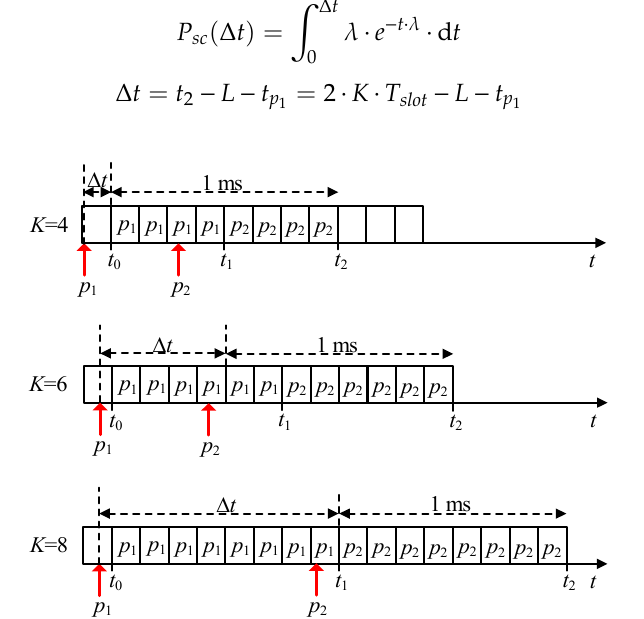
Figure 2. Scenarios with possible self-collisions ( L = 1 ms and K = 4, 6 and 8).